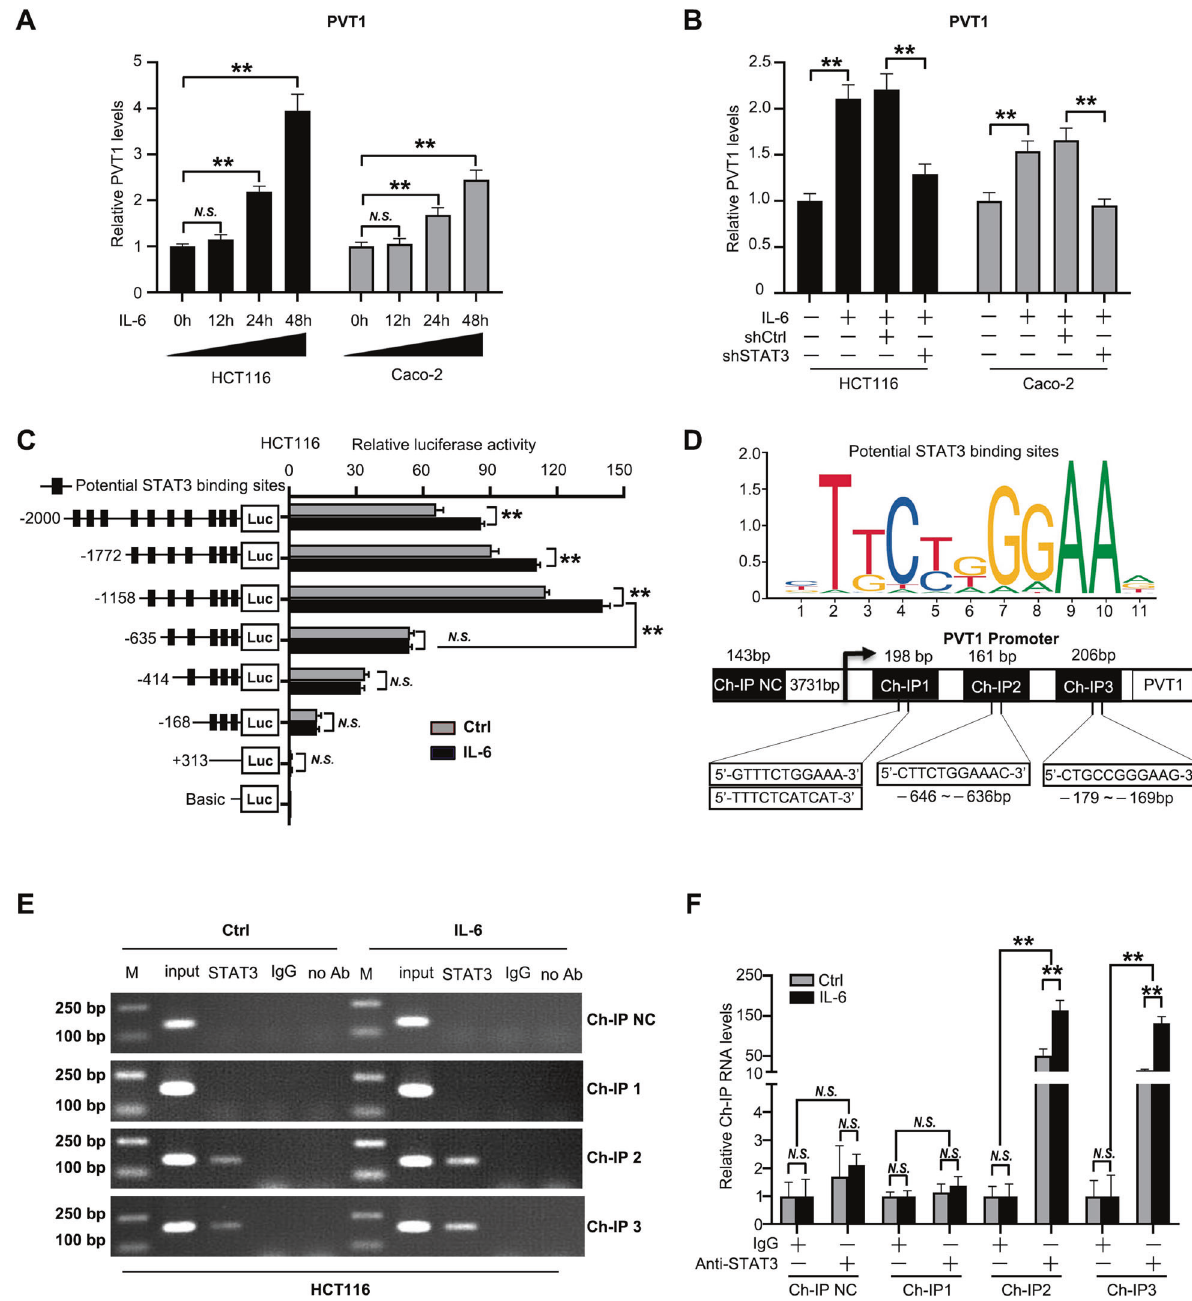
Fig. 7 STAT3 Promotes PVT1 transcription by directly interacting with its promoter. A HCT116 and Caco-2 cells were treated with IL-6 at concentration of 50 ng/mL for 0 – 48 h and expression of PVT1 were examined using qRT-PCR. GAPDH were used as internal control. B HCT116 and Caco-2 cells were infected with STAT3 shRNA and treated with IL-6 (50 ng/mL) or control for 24 h and expression of PVT1 were examined using qRT-PCR. C Serially truncated PVT1 promoter constructs were cloned to pGL3-luciferase reporter plasmids and transfected into HCT116 cells. 48 h after transfection, the relative luciferase activities were determined after IL-6 (50 ng/mL) treatment for 30 min. D Top: Schematic diagram showing the binding motifs of STAT3 in the PVT1 promoter. Bottom: Ch-IP targets the promoter of PVT1. E A Ch-IP assay demonstrated the direct binding of STAT3 to the PVT1 promoter in HCT116 cells. M: Marker. F qRT-PCR of the Ch-IP products validated the binding capacity of STAT3 to the PVT1 promoter. The data are presented as the means ± SDs. * P < 0.05; ** P < 0.01; N.S. not signi fi cant. STAT3 pathway, including IL-1, IL-6, IL-11, CCL3, CXCL8 etc, The integrative analysis of TCGA data and TMA cohort also were also positively correlated with transcripts of CypB and support the results. In CRC tissues, we veri fi ed the positive PVT1 in TCGA cohorts of COAD and READ. These results correlation between PVT1/CypB and STAT3 phosphorylation. suggest that the CypB/STAT3/PVT1 feedback loop is also We showed that both PVT1 and CypB were signi fi cantly present in clinical samples. STAT3 inhibition using Jak correlated with multiple STAT3 downstream targets, which inhibitors such as Ruxolitinib and Momelotinib, has been are important regulators of cell cycle, apoptosis and metastasis. practised in clinical treatment against metastatic CRC [48]. Meanwhile, expression of interleukins that are involved in Cell Death and Disease (2022)